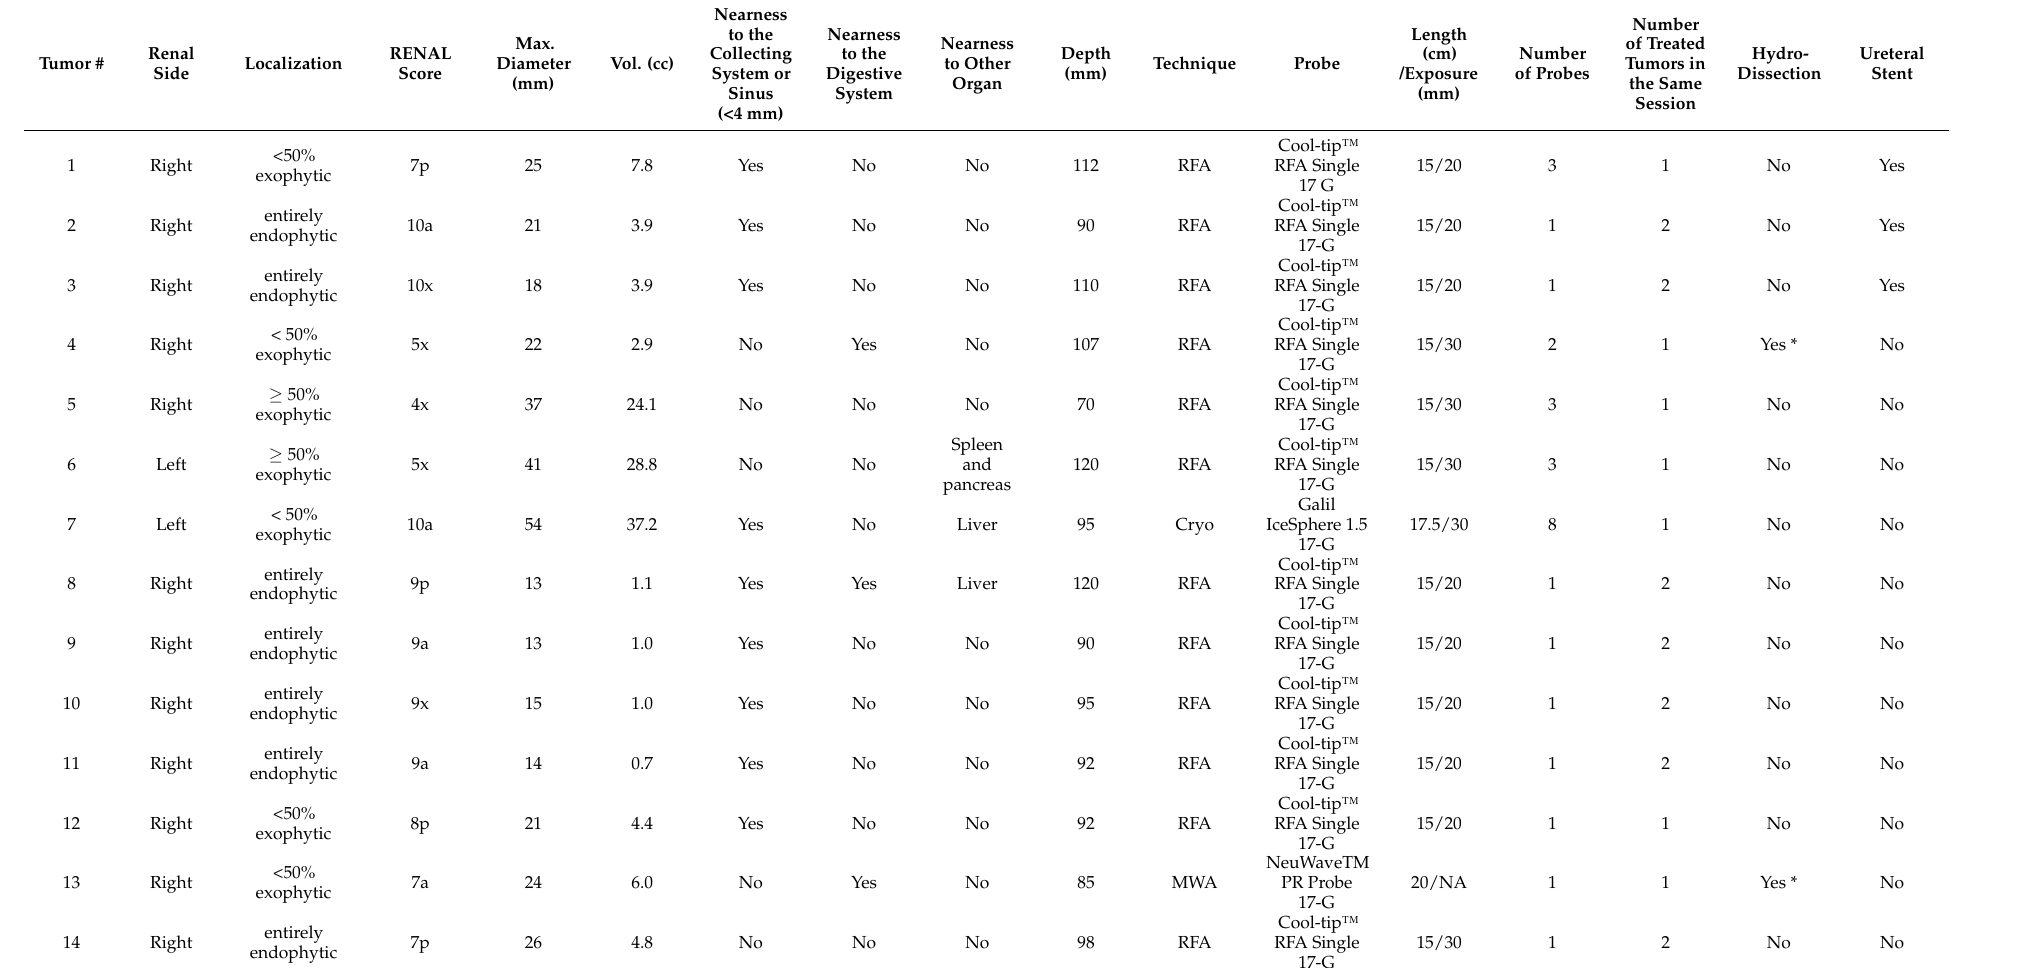
Table 2. Characteristics of the renal cell carcinomas and thermal ablation